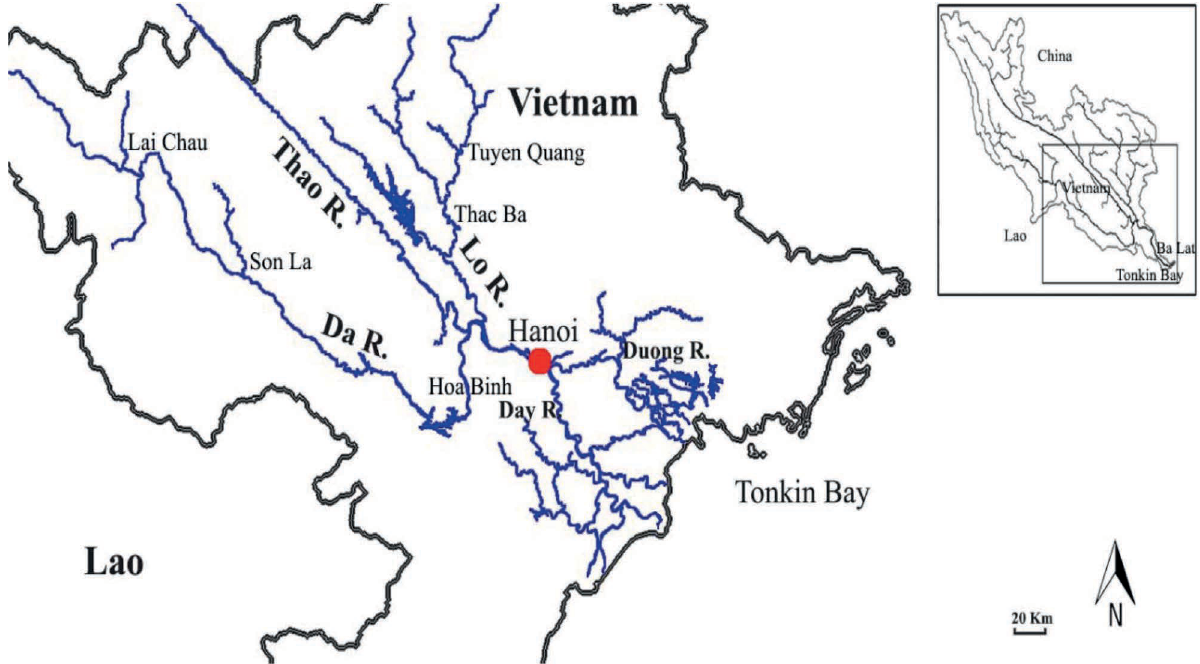
Figure 1 – Map of the Red River system in Vietnam with the location of the sampling site indicated by the red dot. Map produced by using the ‘hydrology’ layer of the maps available at http://vrn.org.vn/ten-river-basins-in-vietnam/ and underlying Google API (©Google 2019). This image is not covered by the terms of the Creative Commons licence of this publication. For permission to reuse, please contact the rights holders (Vietnam Rivers Network, http://vrn.org.vn ; and